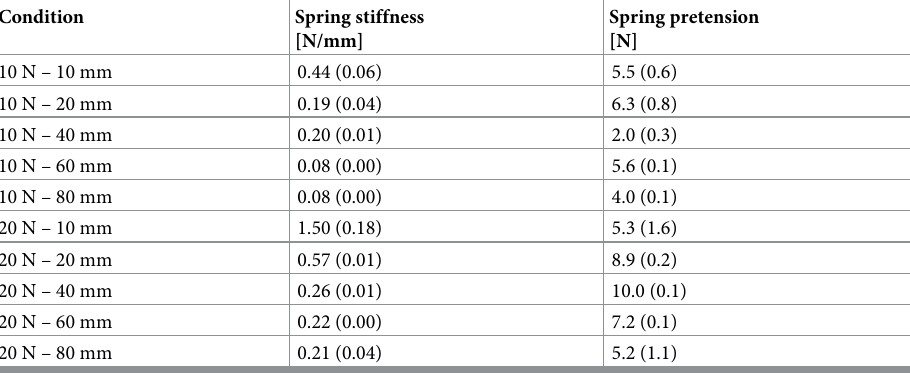
Table 1. Stiffness and pretension of the utilized springs in each